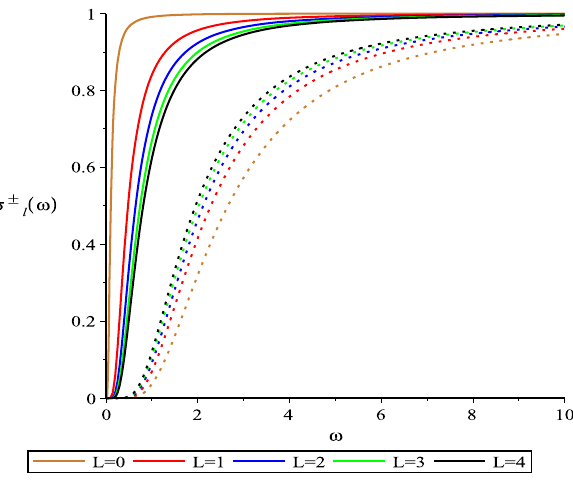
Fig. 2 Plotof V ef f versus r forbosonic(spin- ± 1 While the solid lines stand for the spin-up particles, the dots are for the spin-down particles. The physical parameters are chosen as follows: M = 1, and λ = − 1 . 5